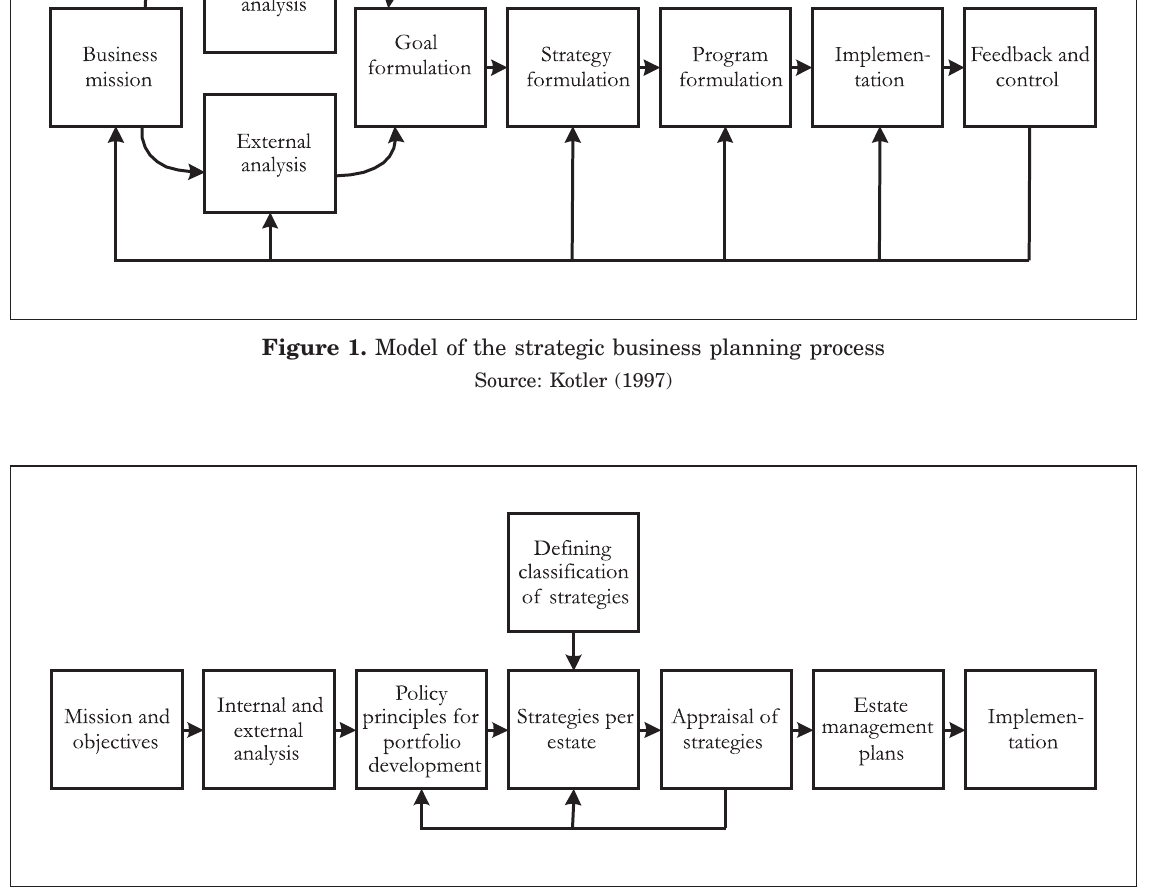
Figure 2. Model for developing asset management